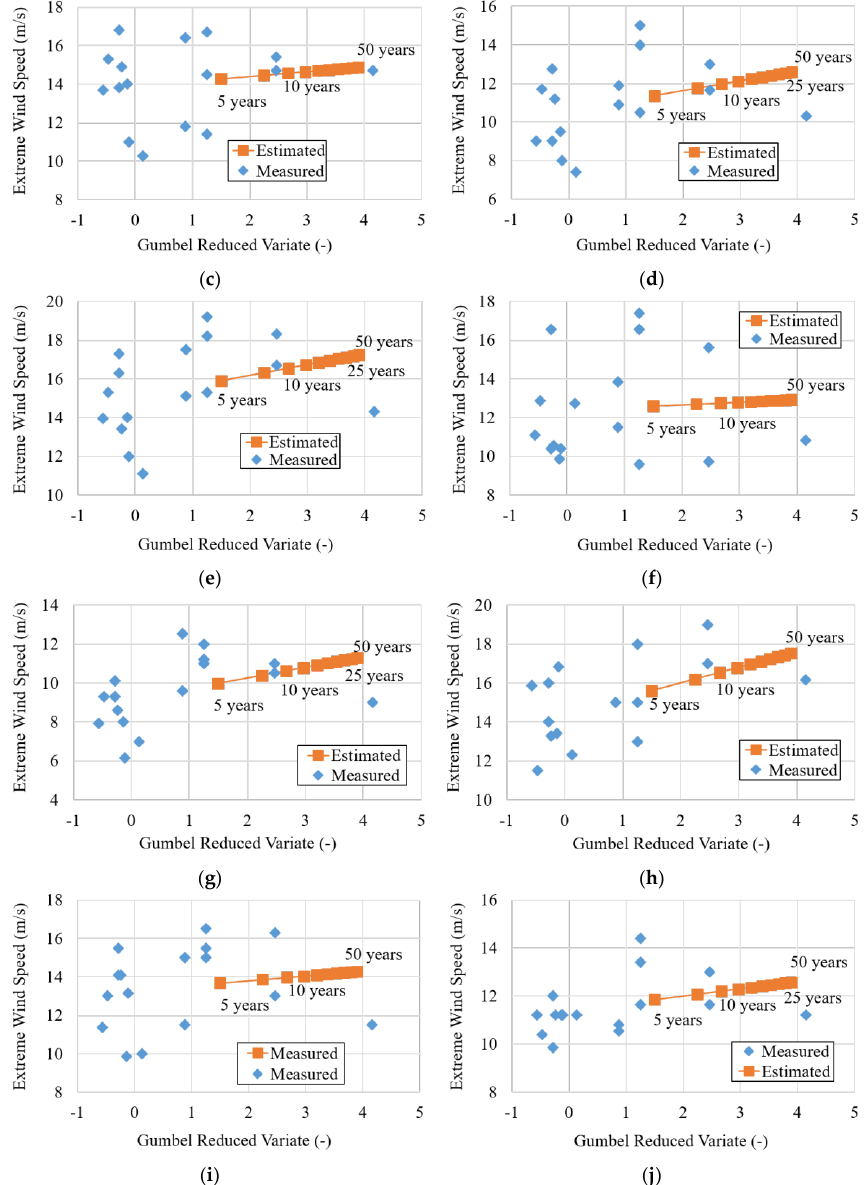
Figure 7. Estimation of EWS (90 m height) at newly proposed wind farm sites ( a ) Site 1; ( b ) Site 2; ( c ) Site 3; ( d ) Site 4; ( e ) Site 5; ( f ) Site 6; ( g ) Site 7; ( h ) Site 8; ( I ) Site 9; ( j ) Site 10 .